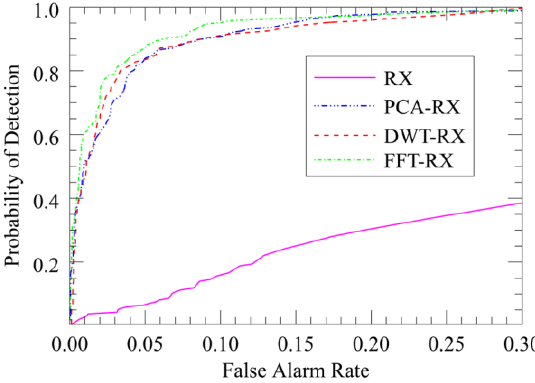
Figure 9. ROC curves of the RX AD family for Img-II.